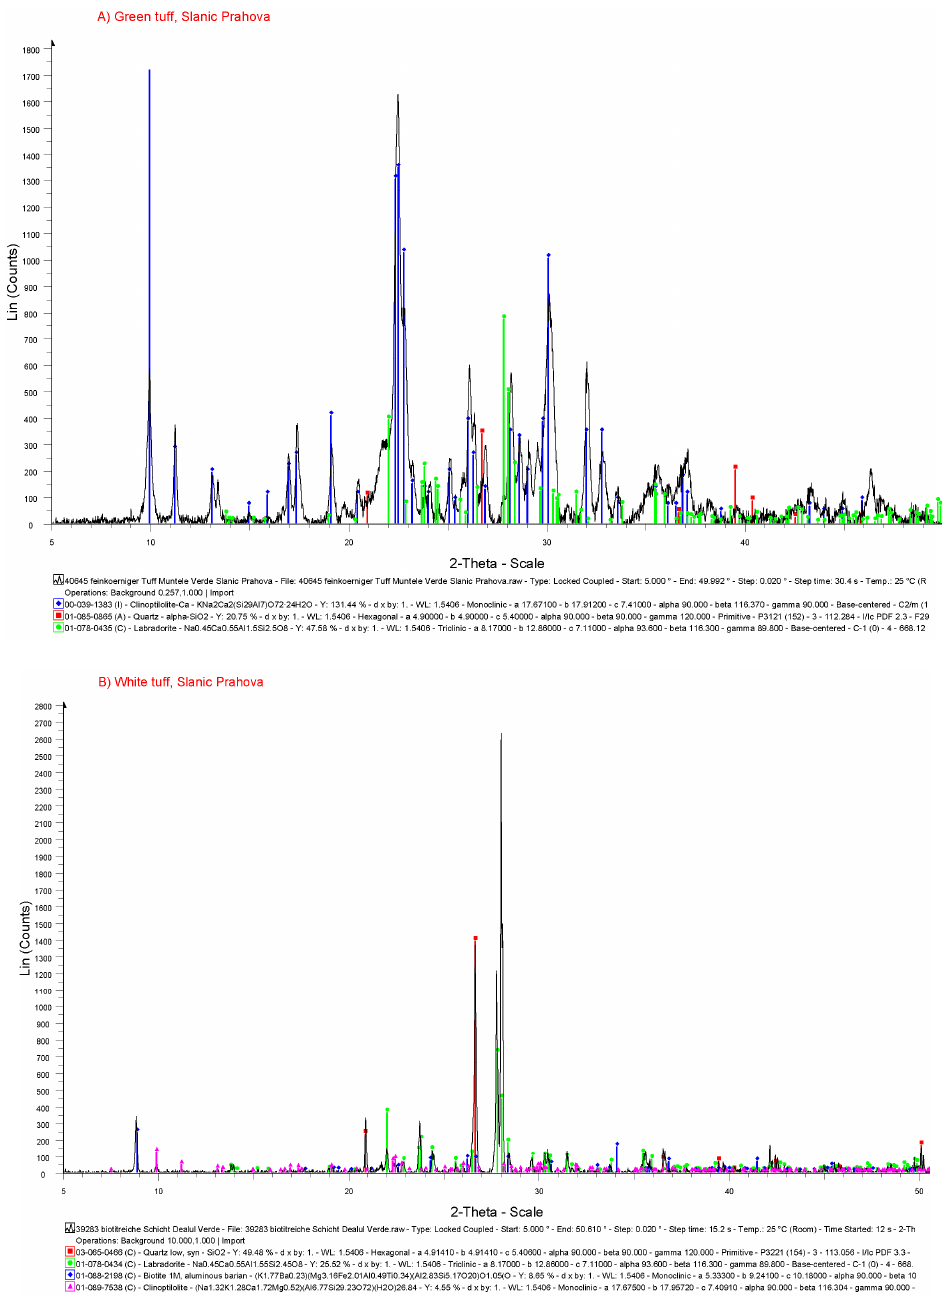
Figure 3. XRD spectra of the mineral components from: ( A ) green tuff and ( B ) white tuff, Green Stone Hill (Muntele Piatra Verde).